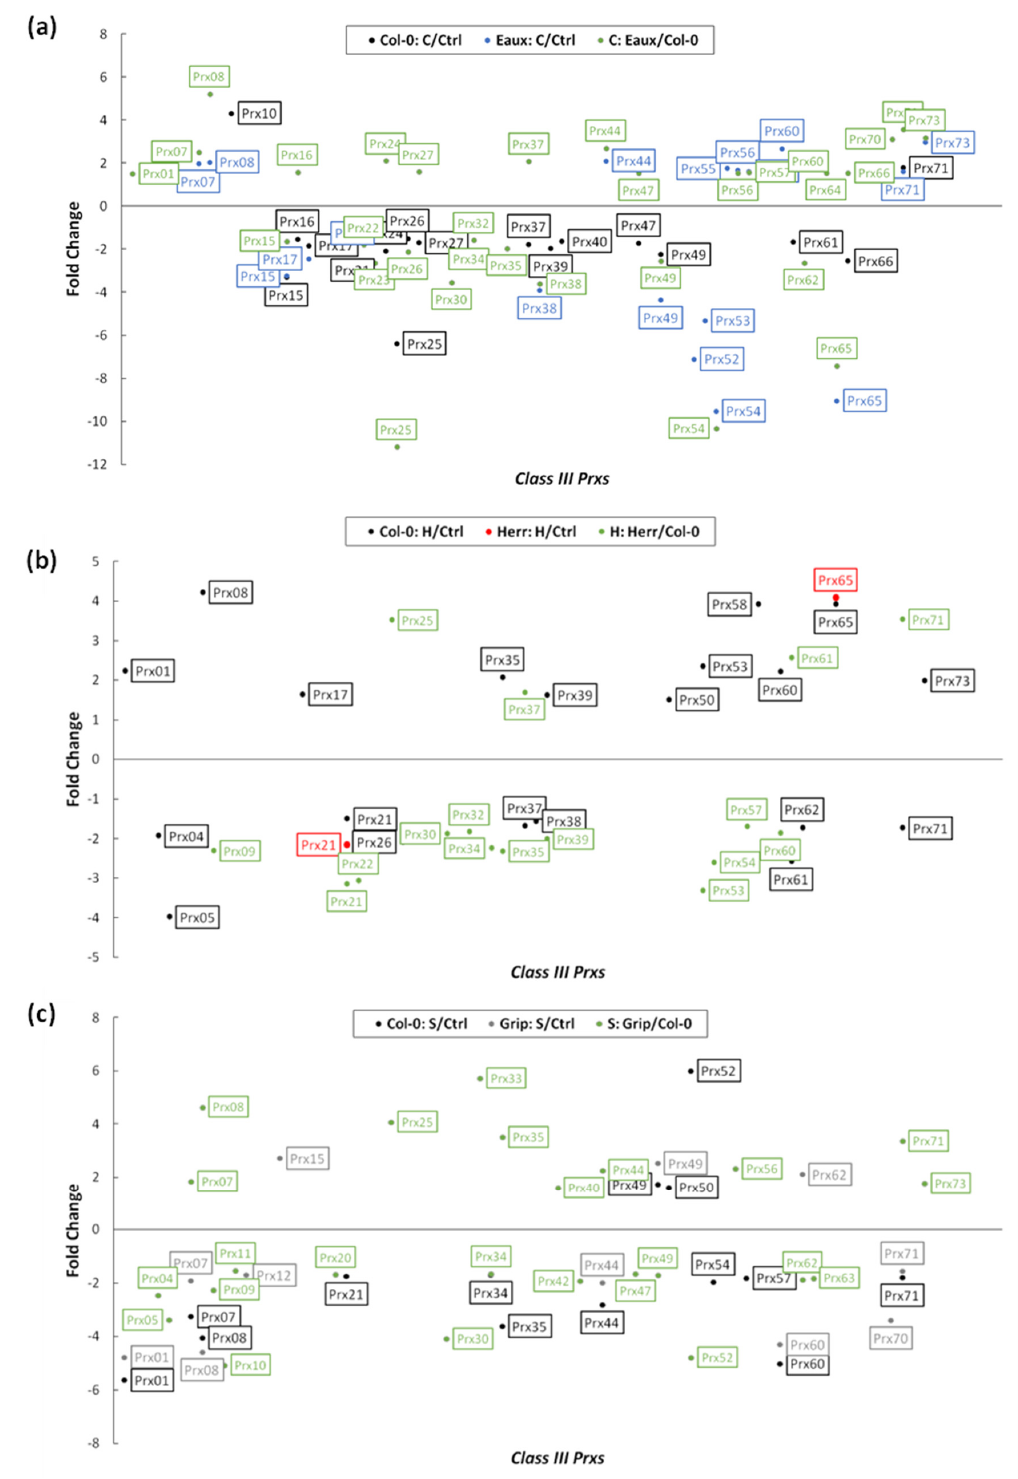
Figure 5. Scatter plots representing the significant differential expression of CIII Prxs (fold change | FC | ≥ 1.5 and false discovery rate FDR ≤ 0.05) in ( a ) Col-0 between cold and control conditions (black), Eaux between cold and control conditions (blue), and in cold conditions between Eaux and Col-0 (green); ( b ) Col-0 between hot and control conditions (black), Herr between hot and control conditions (red), and in hot conditions between Herr and Col-0 (green); ( c ) Col-0 between salt and control conditions (black), Grip between salt and control conditions (grey), and in salt conditions between Grip and Col-0